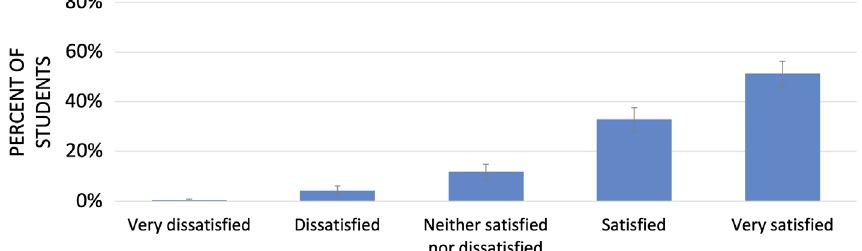
FIG. 8. Student responses ranking satisfaction in their teamwork experience this semester. Uncertainties are calculated using the binomial confidence interval with α ¼ 95%